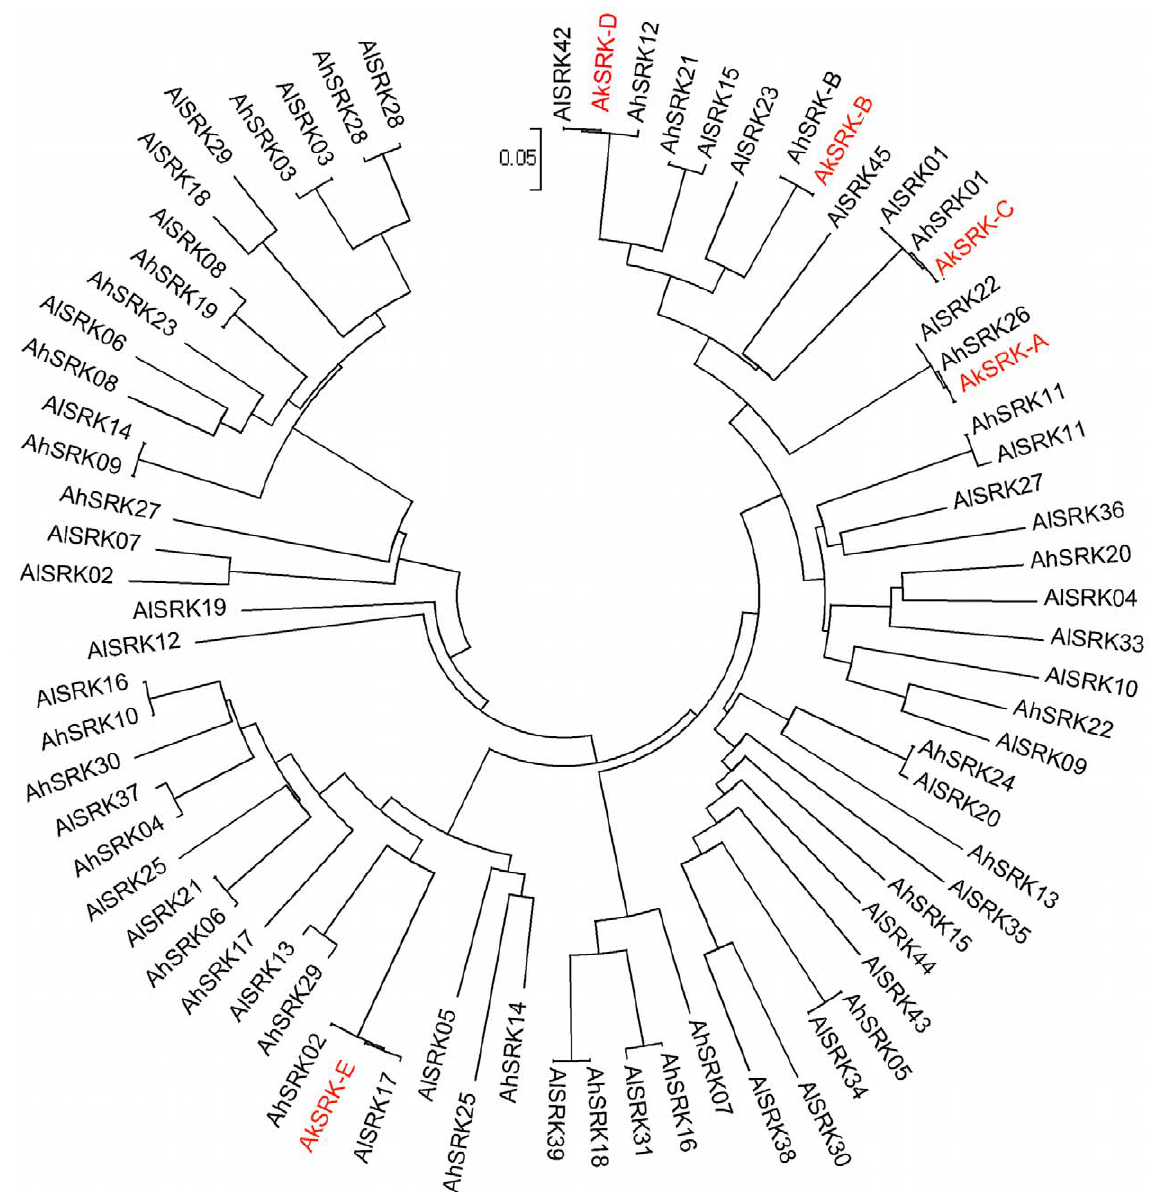
Figure 1. Phylogeny of 76 SRK sequences of A.halleri , A.lyrata , and A.kamchatica . This phylogeny was obtained by the neighbor-joining method on pairwise proportions of nucleotide divergence. In total, 266 nucleotide positions were used. The evolutionary distances were computed using the Kimura two-parameter method. The tree includes 31 SRK sequences of A. halleri ( AhSRK ), 40 SRK sequences of A. lyrata ( AlSRK ) and five SRK sequences of A. kamchatica ( AkSRK ). See Table S10 for the accession numbers of these sequences deposited in GenBank. SRK sequences of A. halleri and A. lyrata are shown in black, and those of A. kamchatica are shown in red.